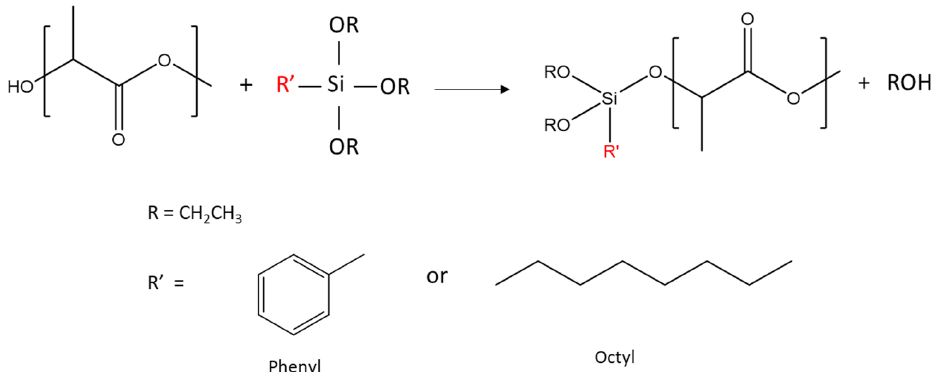
Figure 1. Reaction schemes between PLA hydroxyl end groups and alkoxysilanes. Only OR exchange is shown here.